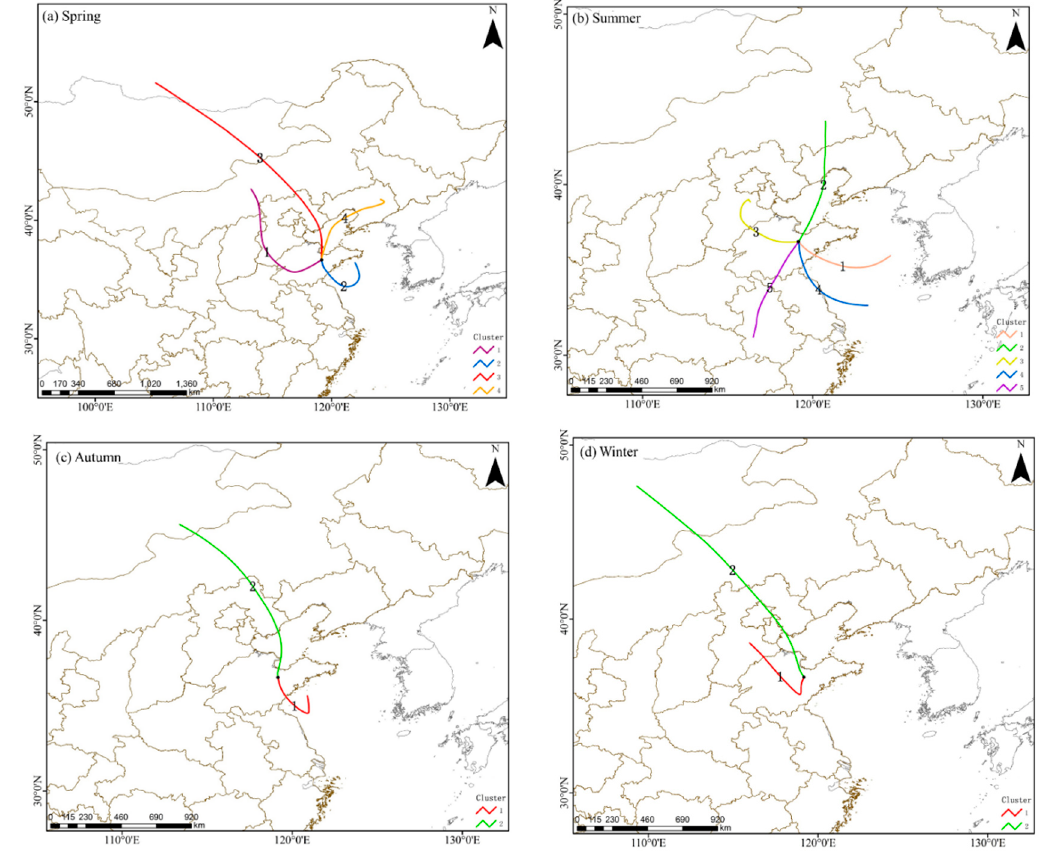
Figure 4. Cluster mean back-trajectories in different seasons in Weifang from March 2015 to February 2016.